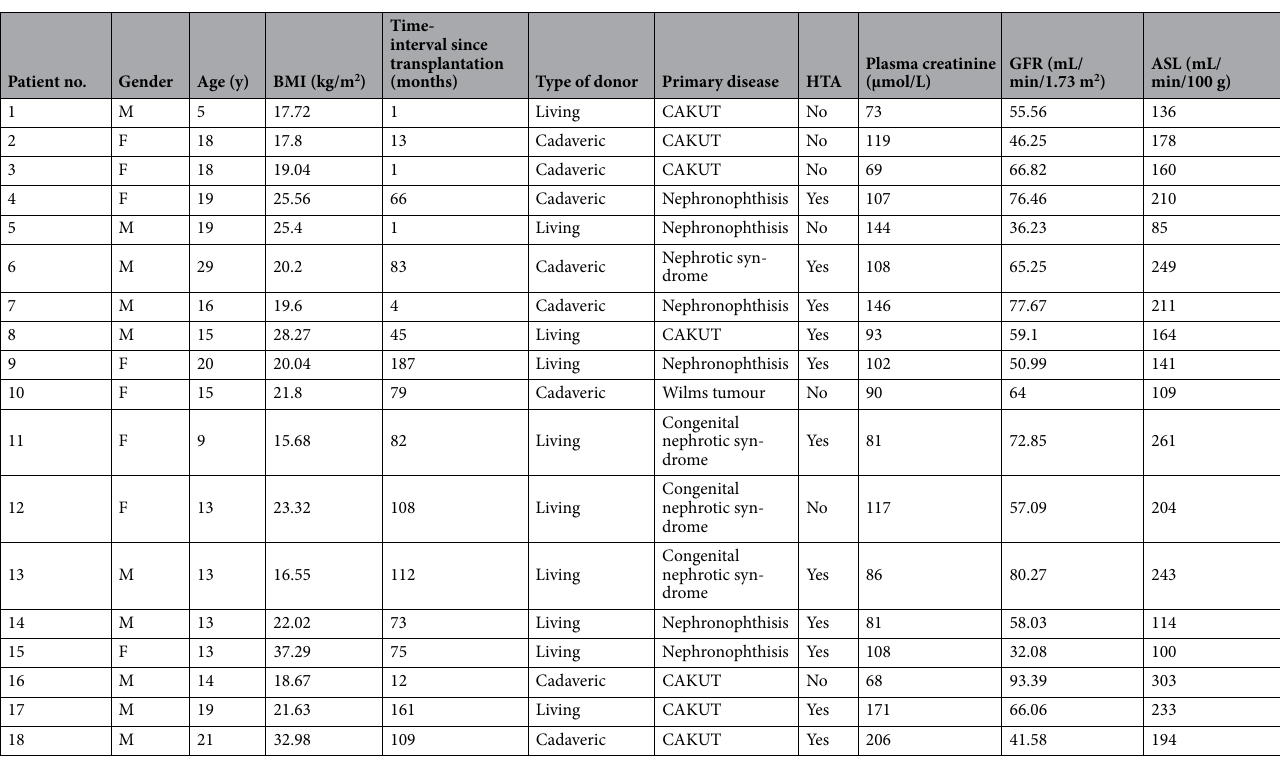
Table 1. Clinical data of the patient population included in this study. M: male; F: female; BMI: body mass index; HTA: hypertension; GFR: glomerular filtration rate; ASL: arterial spin labelling perfusion; CAKUT: congenital anomalies of the kidney and urinary